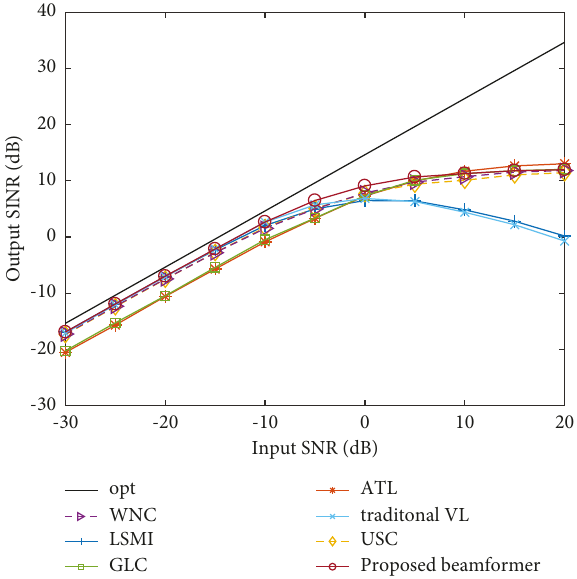
Figure 6: Output SINR versus input SNR in finite